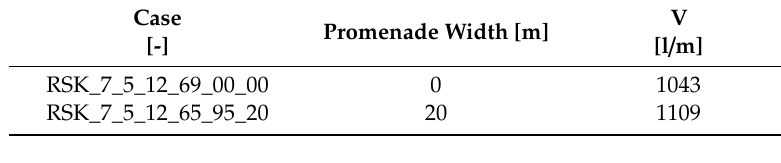
Table 2. Individual overtopping volumes for selected cases. Table 2. Variation of test parameters and the values.